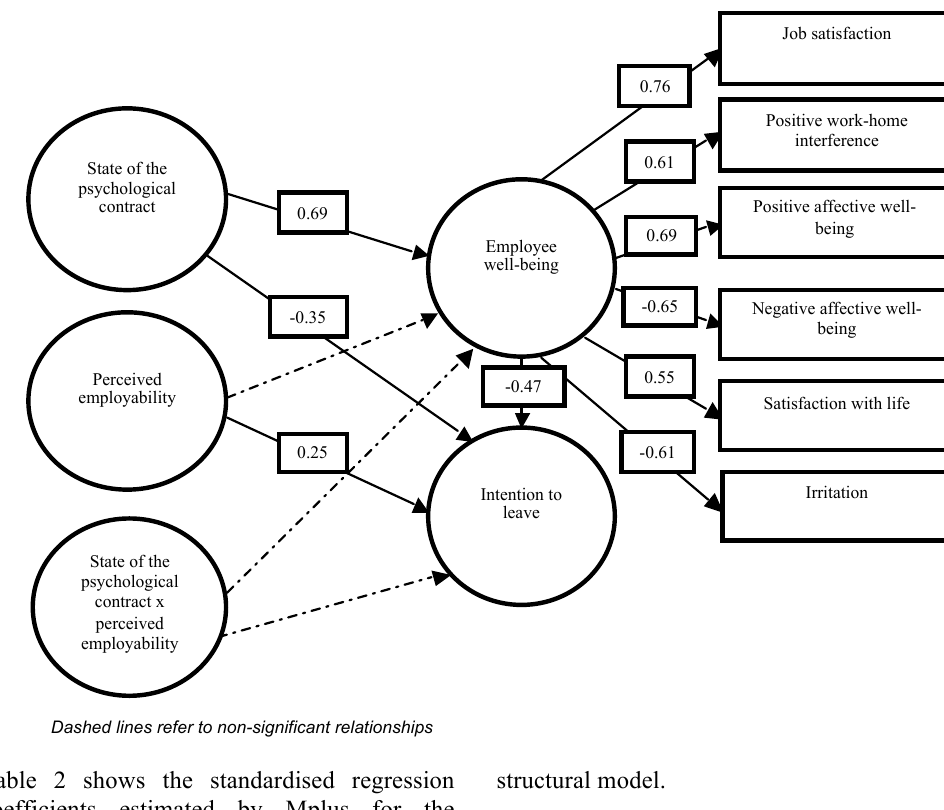
Dashed lines refer to non-significant relationships